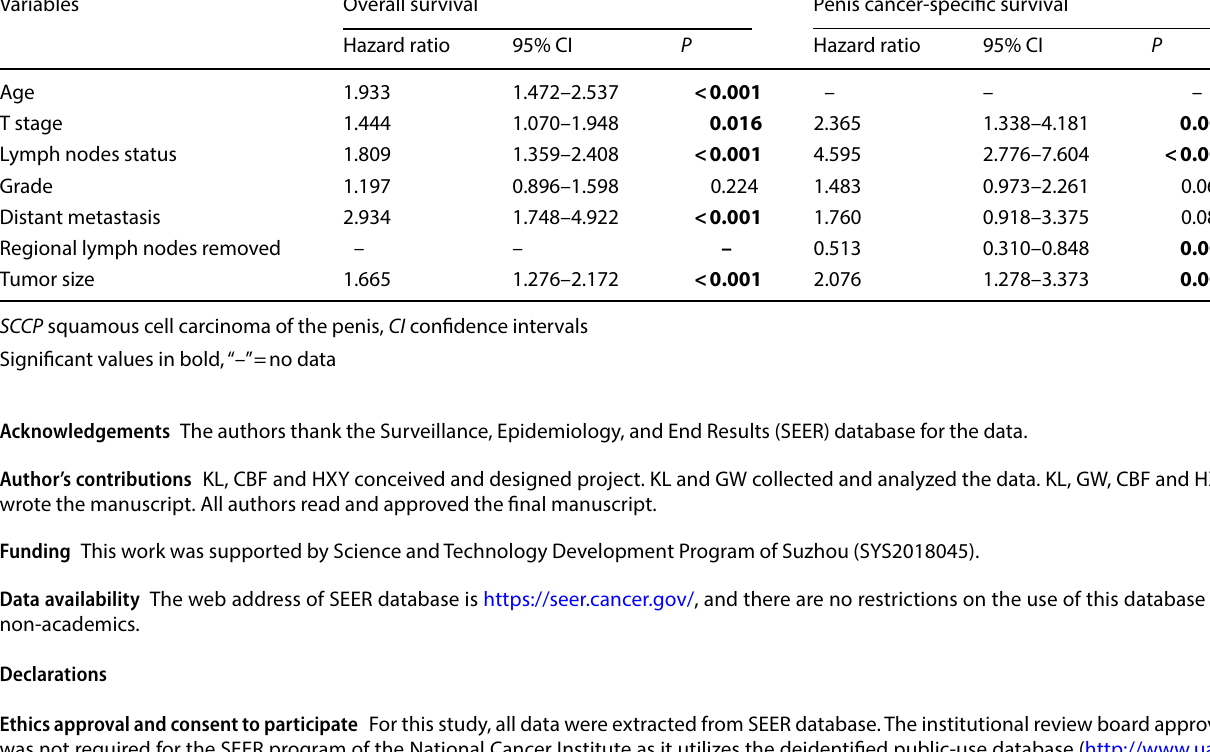
Table 3 Multivariate Cox regression analyses predicting overall survival and penis cancer-specific survival in 1001 patients with SCCP